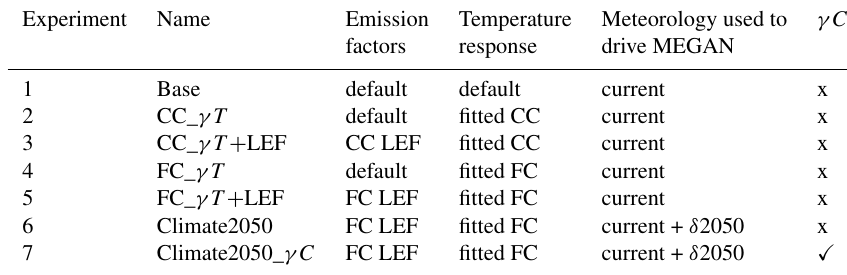
Table 4. Description of each model experiment. CC: current climate; FC: future